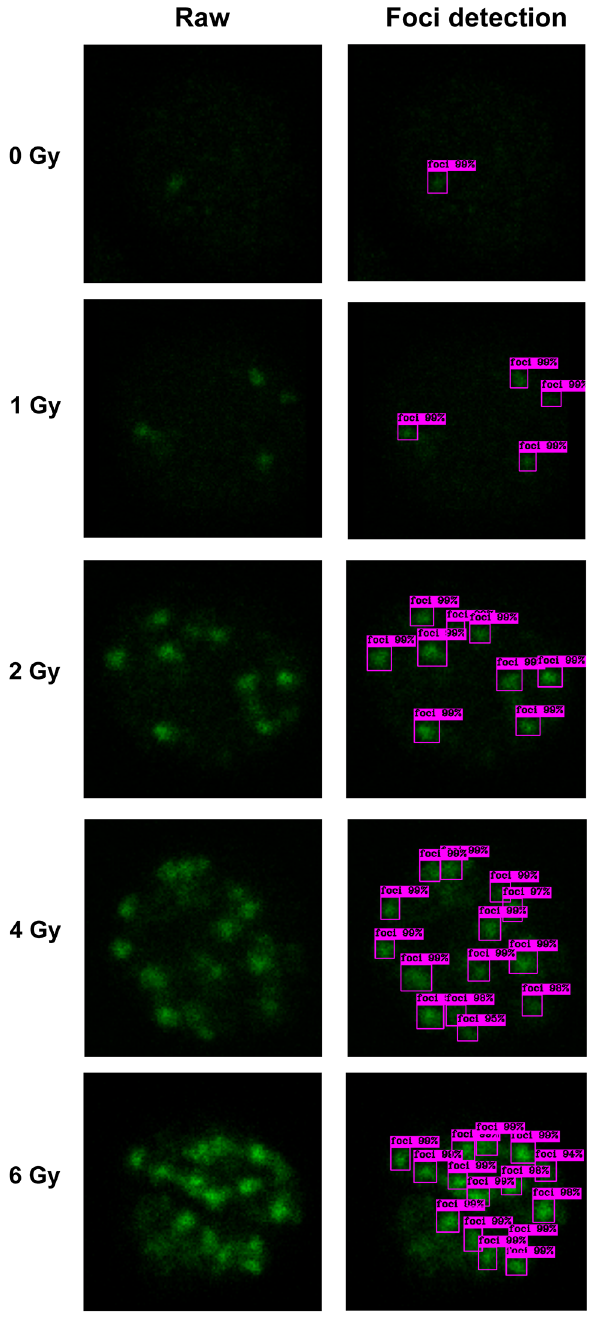
Figure 4. Performance testing of the FociRad. Green channel cropped images of cells irradiated with X-rays (0, 1, 2, 4 or 6 Gy) (left column) and automated foci detection with confidence thresholds by the FociRad model (right column) are